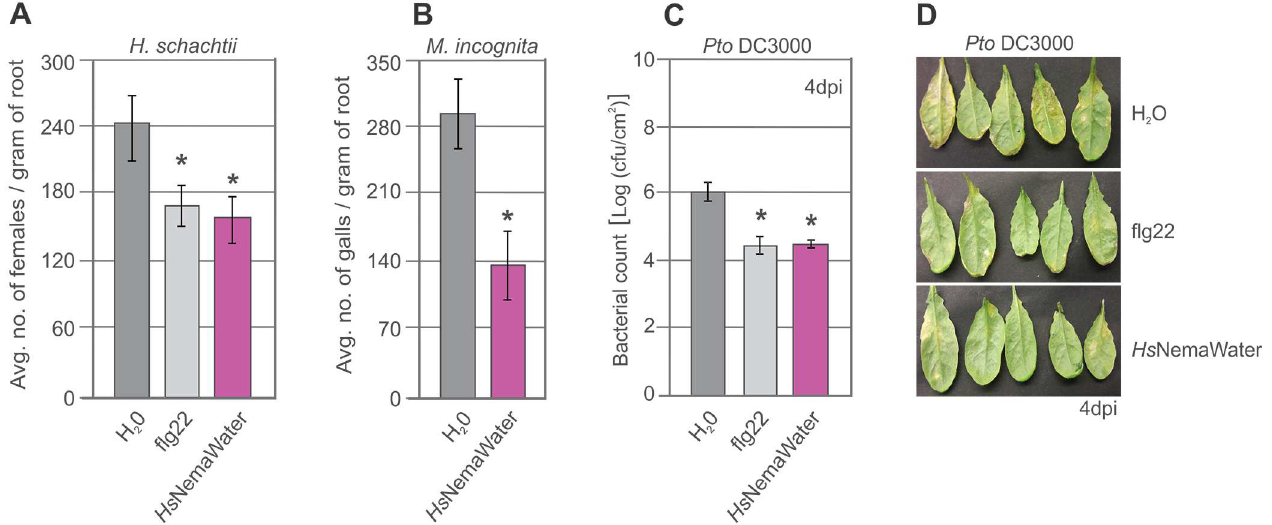
Fig 3. Pre-treatment with NemaWater induces resistance to pathogens. (A-B) Roots of Col-0 plants were treated with water or Hs NemaWater prior to infection and number of females were counted at 14 dai for cyst nematodes and number of galls were countedat 19 dai for root-knot nematodes. Bars represent mean ± SE for three independentbiological replicates. (C-D) Plants were sprayedwith flg22 or Hs NemaWater prior to inoculation and C. F.U/cm 2 was counted at 4 dai. Bars represent mean ± SE. Experiments were repeatedthree times with similar results. Asterisks represent significantdifference to water-treated control root segments(P <